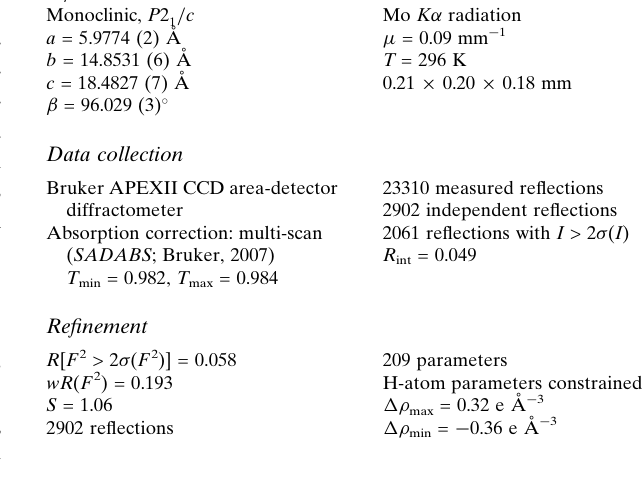
molecule. In the 1,5-phenyl-